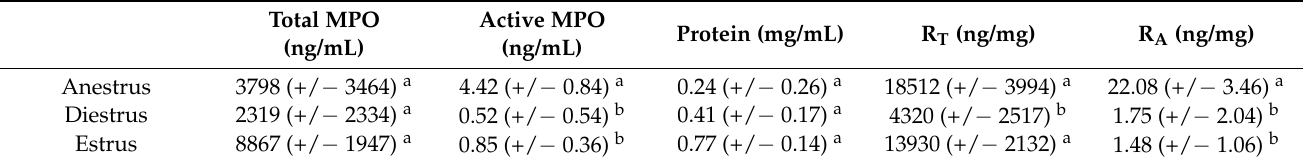
Table 1. Least squares means (+/ − standard error) values of total and active myeloperoxidase (MPO), protein, total MPO/total protein ratio (R T ) and active MPO/total protein ratio (R A ) in uterine lavages in mares in the studied phases: anestrus, diestrus and